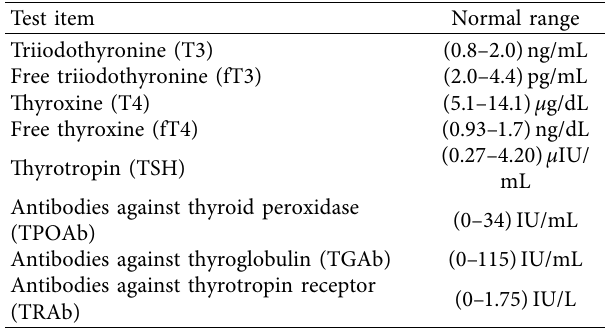
Table 1: Normal ranges of thyroid function parameters and thyroid